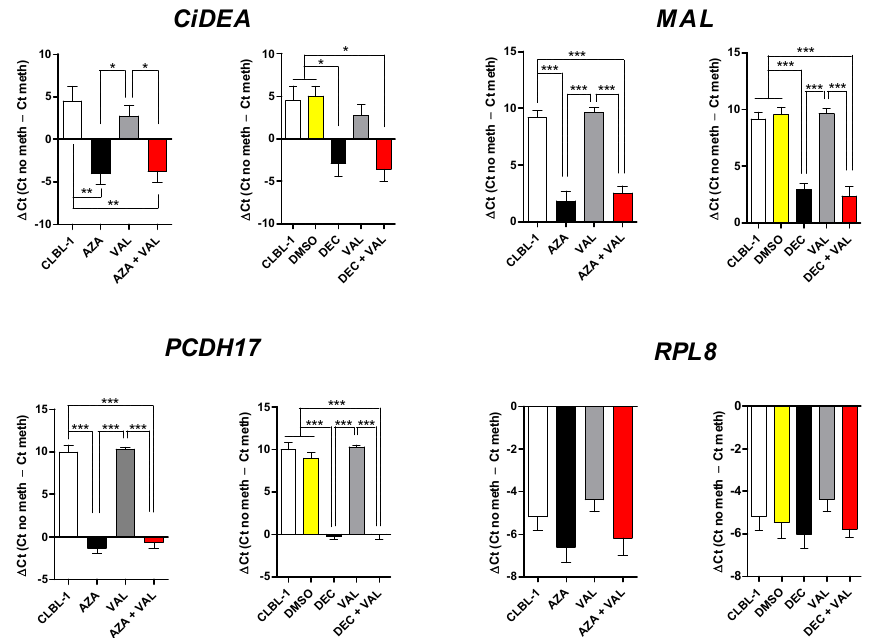
Figure 5. Effect of the treatment with AZA or DEC in combination with VAL on CiDEA, MAL , PCDH17 and RPL8 methylation status in CLBL-1 cells. For each gene, the results of AZA are in the graph on the left, while the results of DEC are in the graph on the right. The results of MSP analyses (qPCR) are expressed as ∆ Ct (=Ct No meth − Ct meth), as the mean ± SEM of four independent experiments. Statistical analysis: ANOVA + Bonferroni post hoc test. (*: p < 0.05; **: p < 0.01; ***: p < 0.001). RPL8 (the negative control gene) was not affected by the treatment as expected.